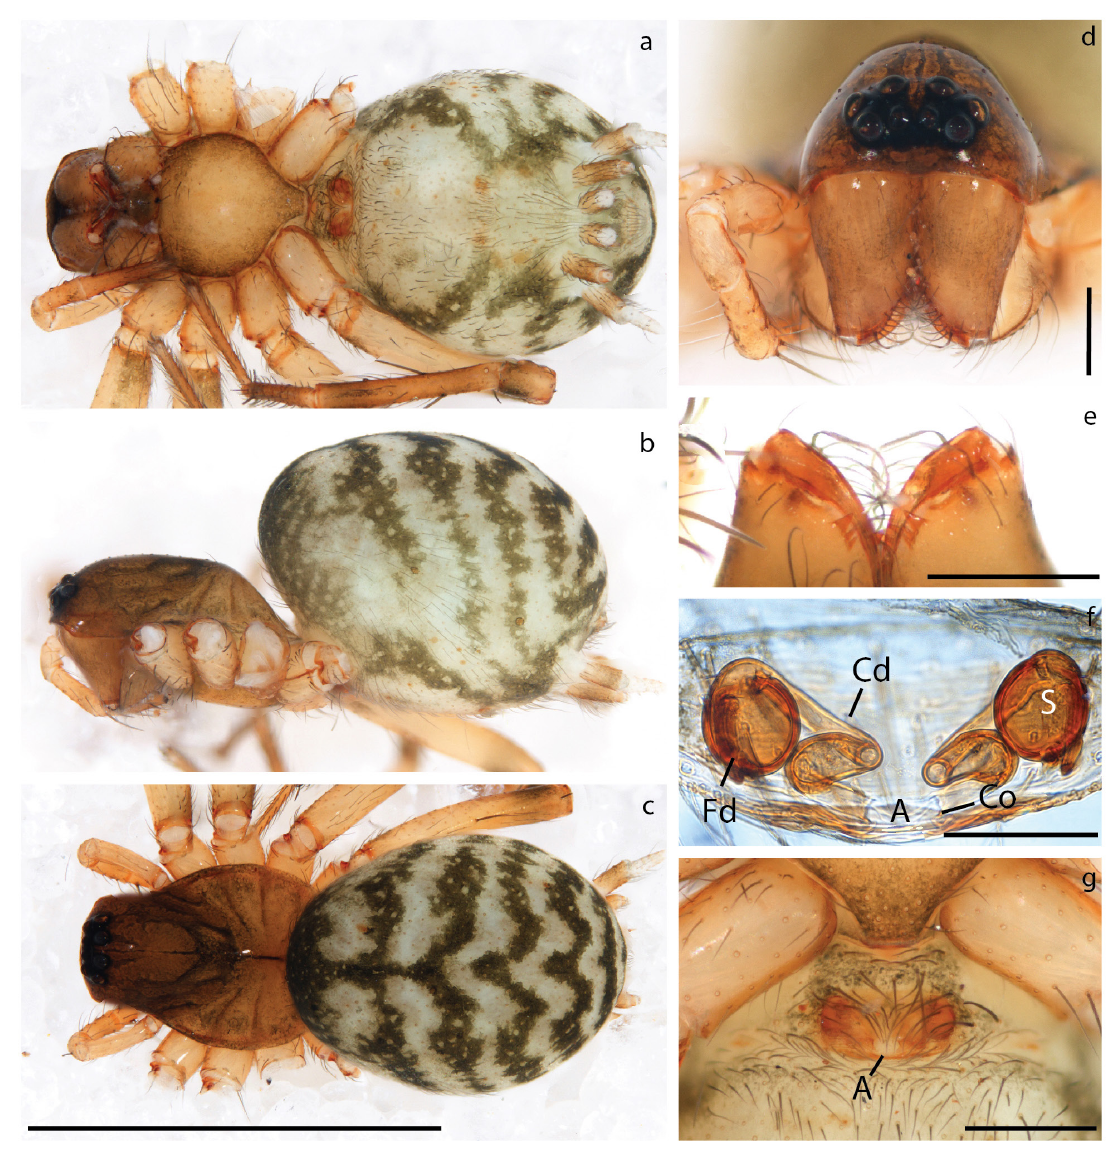
Fig. 4. Hahnia ngai sp. nov., holotype, ♀ (RMNH.ARA.18415). a–c . Habitus. a . Ventral view. b . Lateral view. c . Dorsal view. d . Prosoma, anterior view. e . Chelicerae, posterior view. f–g . Epigynum. f . Dorsal view, cleared. g . Ventral view. Scale bars: a–c = 1.0 mm; d–e, g = 0.25 mm; f = 0.1